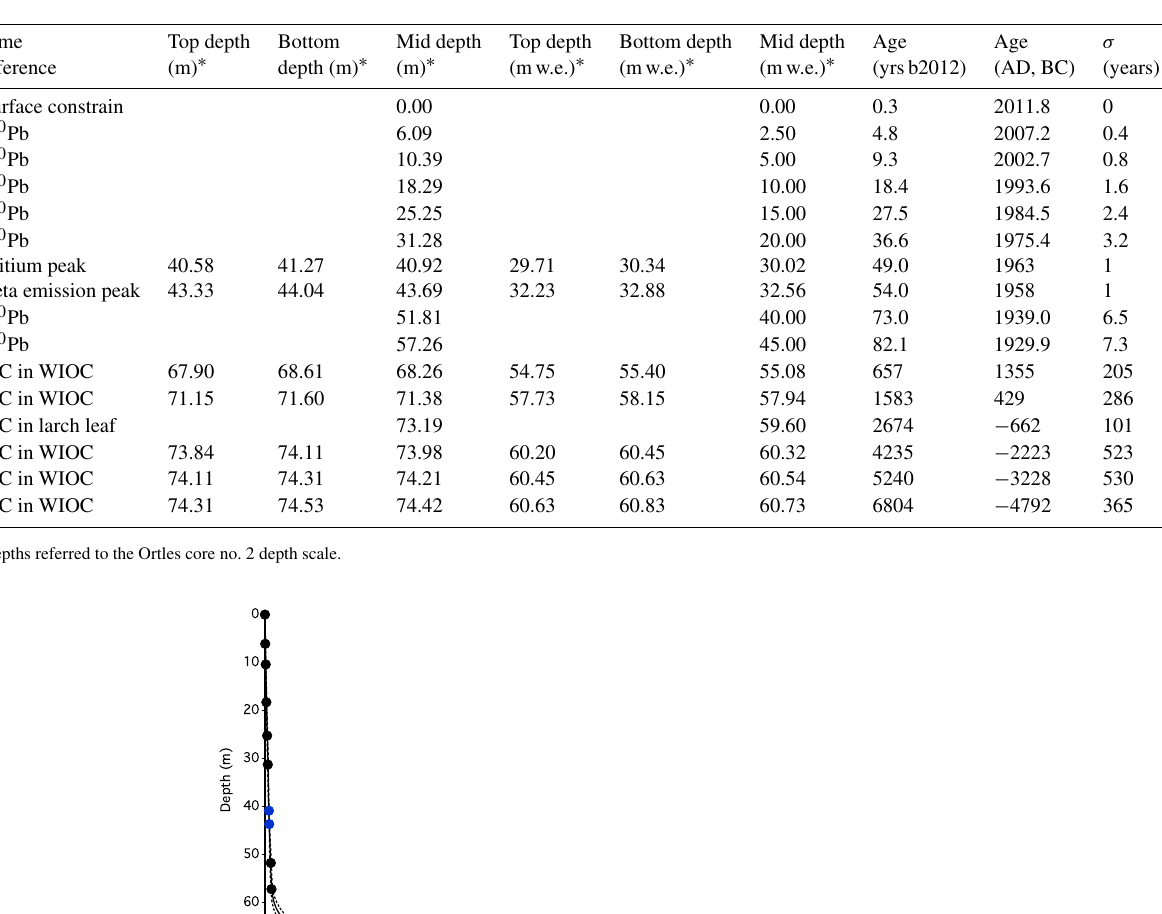
Table 3. Data used in the depth–age modelling.